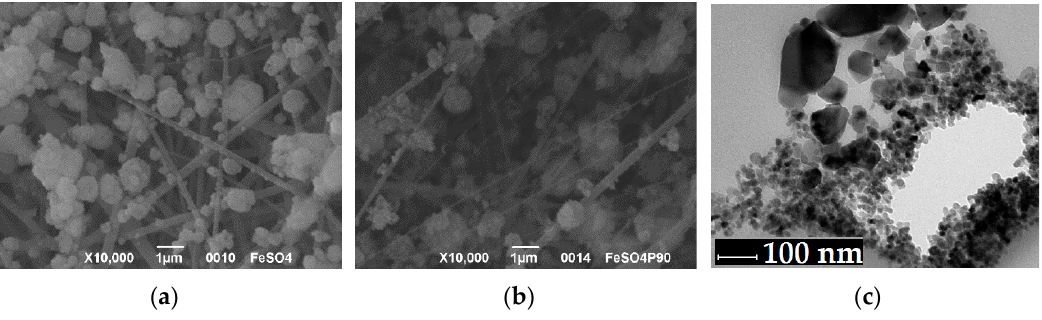
Figure 5. SEM images of ( a ) PAN_Fe and ( b ) PAN_TiO 2 _Fe membranes; ( c ) TEM image of PAN_TiO 2 _Fe membrane.